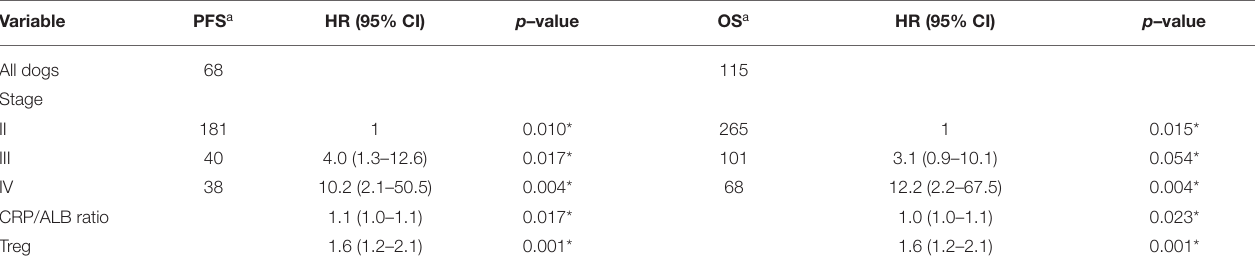
TABLE 4 | Effect of clinical stage, surgical margins, inflammatory indices (NRL, PLR, MLR, SII, and CRP/ALB ratio), albumin, LDH, and frequency of circulating cells (lymphocytes CD4, CD8, CD4/CD8 ratio, Tregs, (M)-MDSCs, and (PMN)-MDSCs) on the PFS and OS of 25 canine patients with oral melanoma.